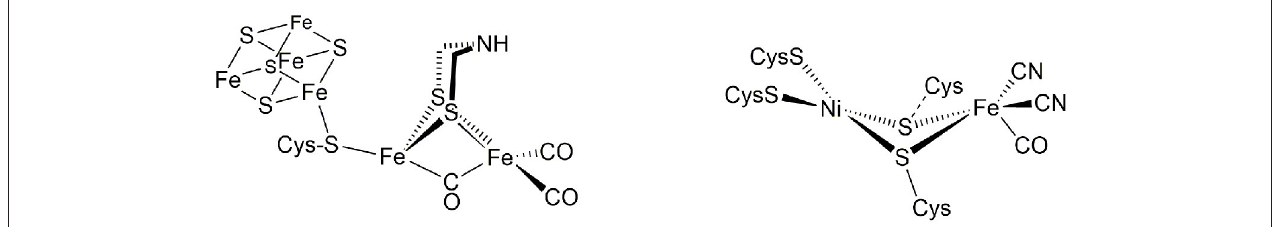
FIGURE 1 | Active sites of [FeFe]- and [NiFe]-hydrogenase